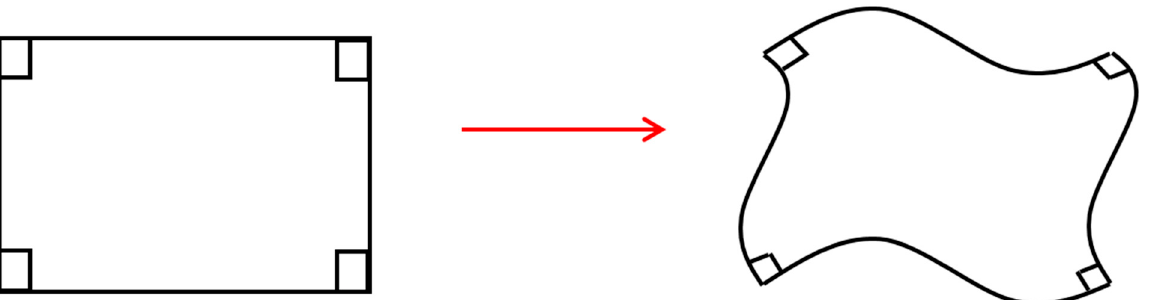
Figure 3. Assumption of constant plate edge angles.